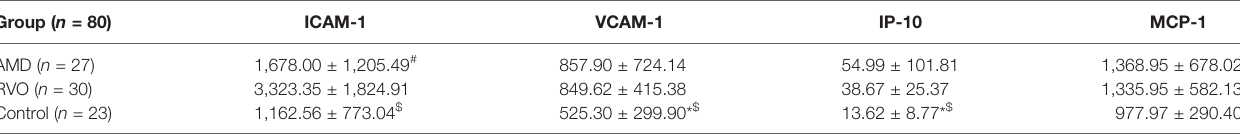
Intercellular cell adhesion molecule-1 (ICAM-1), Inducible protein-10 (IP-10), Monocyte chemoattractant protein-1 (MCP-1), Vascular cell adhesion molecule-1 (VCAM-1). Data are expressed as the means ± standard deviations (SD), in pg/ml. The differences in cytokines between the 2 groups were tested using Student ’ s t-test. *p < 0.05 between the AMD